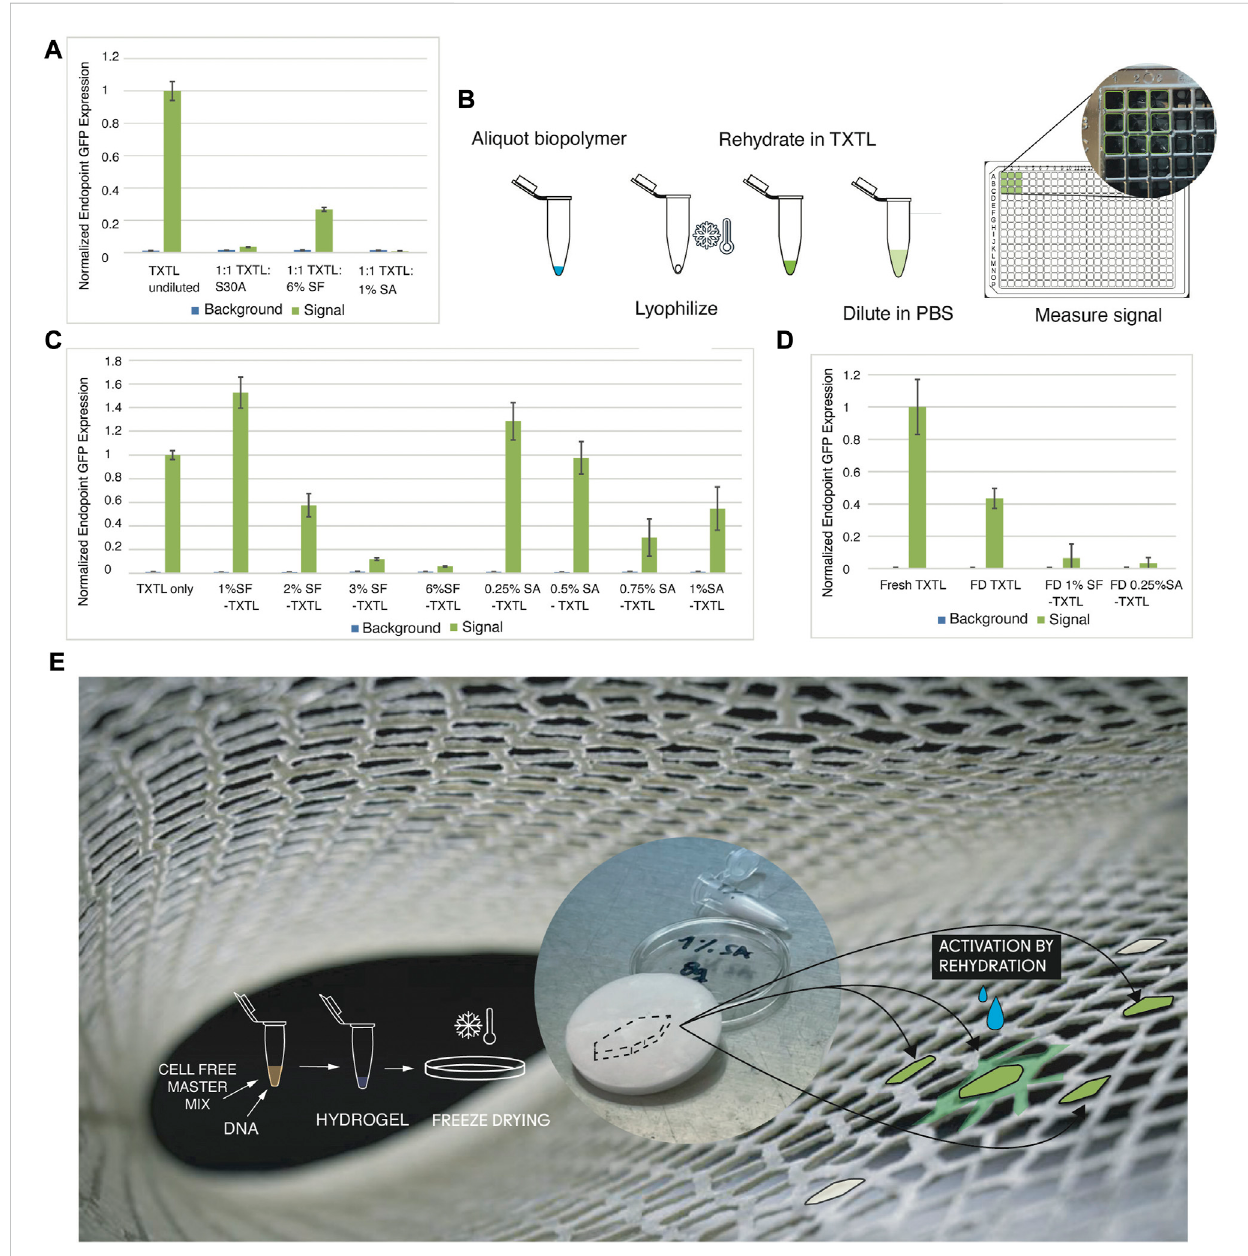
FIGURE 2 Microscale Design Methodology: TXTL Expression of GFP in Biopolymer Mixes. (A) Relative expression of TXTL when compared to 1:1 dilution in S30A Buffer, 6% SF, and 1% SF after incubation at 16H, 27 ° C. (B) To increase concentration of biomaterials without diluting TXTL mixes and overcome handlinglimitationsofhighly concentratedbiomaterials,welyophilizeappropriateamountsandrehydrateinTXTLusing1.5 mLEppendorfvials.3 μ Lwas expressedfor16H,27 ° C,thendilutedin22 µLPBSandmeasuredbytransfertoa384wellplate(with3.65 mmdiameterwells). (C) Usingthemethod from (E) theeffectonTXTLofSFfromarangeof1% – 6%andSAfromarangeof0.25% – 1%weretested.Thehighestexpressingconcentrations,1%SFand 0.25% SA, were selected for subsequent experiments. (D) We tested the performance of lyophilized TXTL-1% SF and lyophilized TXTL-0.25% SA pellets after simple rehydration with water. (E) Envisioned and simpli fi ed design work fl ow to produce biosites in our future work consisting of TXTL protein expression in freeze dried bioblends embedded in robotically extruded structural lattices to be activated by hydration (background image is of printed